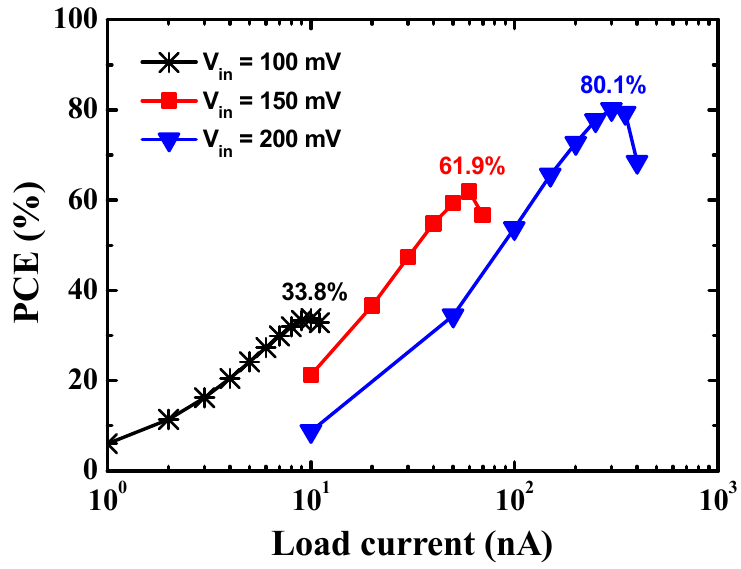
Figure 11. PCE according to the load current in different input voltage conditions of the proposed charge pump.